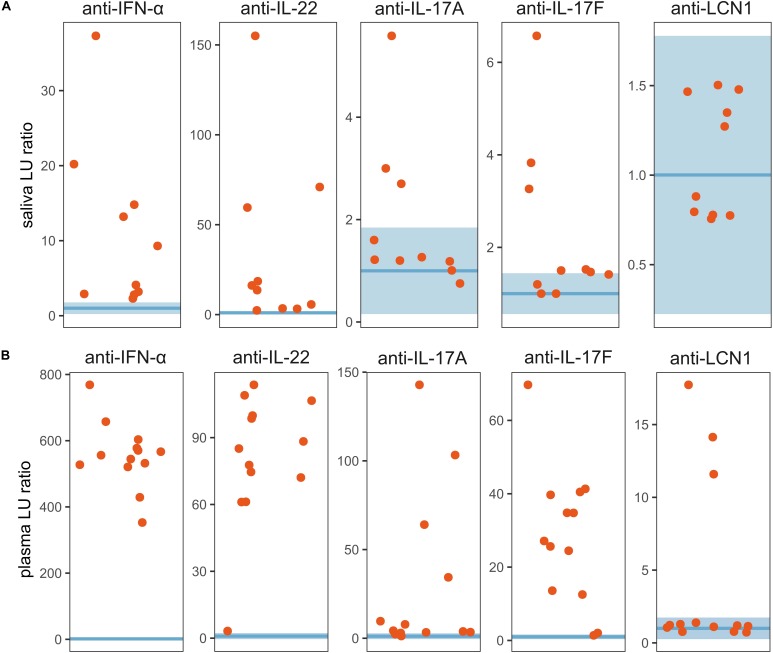
Autoantibodies from saliva and plasma. LIPS assay was conducted on (A) saliva samples (10 patients and 10 controls) and on (B) plasma samples (13 patients and 7 controls). The results were expressed as luminescence units (LU) representing the fold over the mean of the heathy control samples. The horizontal blue line represents the geometric mean of the LU of the control sample group (saliva n = 10, plasma n = 7). The transparent blue area shows normal range e.g., ±3 standard deviations of the geometric mean.